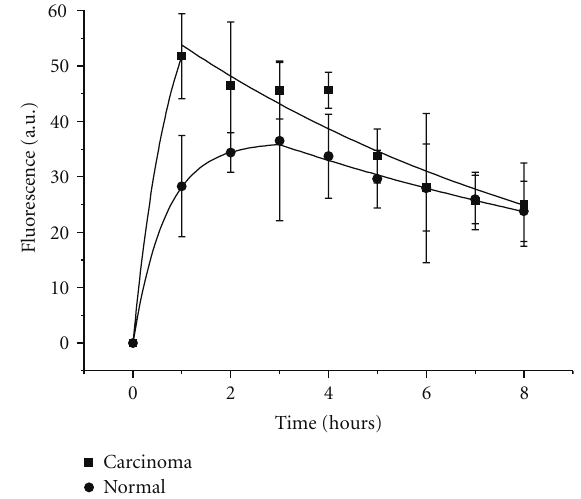
Figure 5: Fitting of the accumulative evolution as well as the elimination time evolution with the equations presented in the text.